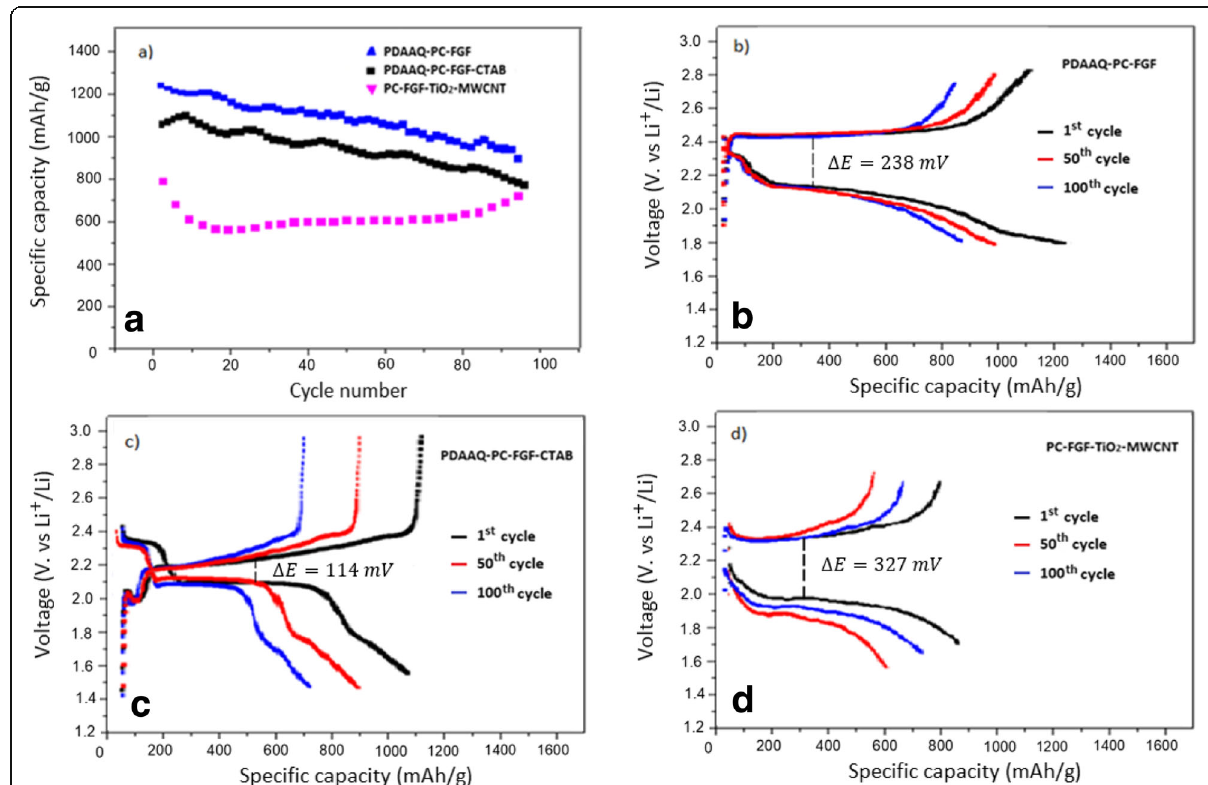
Fig. 3 a Cycling performance of Li-S cells with PDAAQ/PC-FGF/S cathode and three different coated separators at current density of 0.5 C. b Galvanostatic charge/discharge profiles for the 1st, 5th, 100th cycles of Li-S cells with PDAAQ/PC-FGF, c PDAAQ/PC-FGF/CTAB, d PC-FGF/TiO 2 - MWCNT interlayers at 0.5 C with potential window of 1.5 – 3 V versus Li + /Li